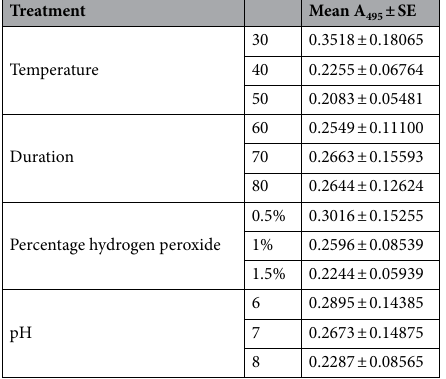
Table 1. Descriptive statistics for the effect of temperature, time, pH and percentage hydrogen peroxide on decolorization of biosurfactant